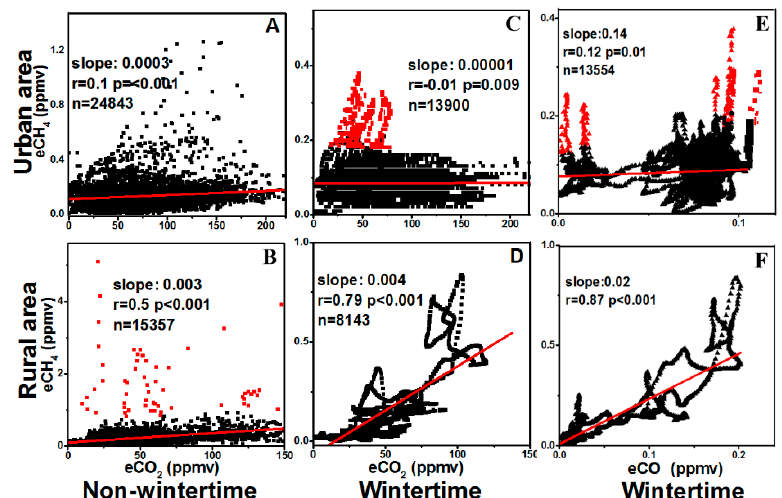
Figure 5. Correlation analysis of CH 4 and CO 2 enhanced concentrations in the non-wintertime in the urban area (A) and in the rural area (B) and in the wintertime in the urban area (C) and in the rural area (D) and of CH 4 and CO enhanced concentrations in the wintertime in the urban area (E) and in the rural area (F). For the rural area measurement, three measurement data were merged for each figure. The slope, the regression coefficient (r) and the confidence level ( p ), the number of observations (n), are also shown. Note that the scales are different for urban and rural areas. The red lines are the linear regression results. In B, C, and E, the red dots represent the measurements of obvious fugitive CH 4 and they were not used in the regression analysis.